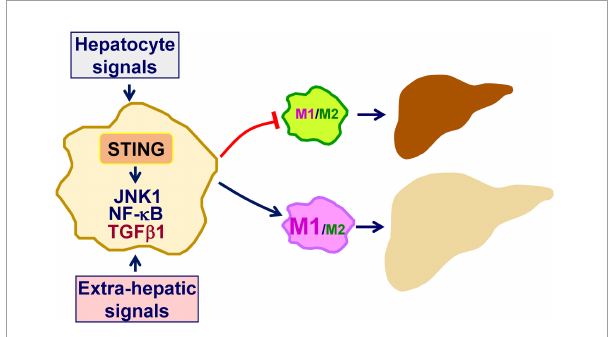
FIGURE1 Macrophage STING promotes the pathogenesis of NAFLD. As a mediator of innate immunity, stimulator of interferon genes (STING) also exerts a crucial role in regulating inflammation. Within macrophages, double-stranded DNA (dsDNA) generated in response to mitochondrial dysfunction or endoplasmic reticulum stress activates cyclic GMP-AMP (cGAMP) synthase (cGAS) to increase cGAMP production. The latter, in turn, activates STING to promote macrophage proinflammatory activation. Inside the liver, hepatocytes are a key source that releases dsDNA including mitochondrial DNA and fragment DNA when under